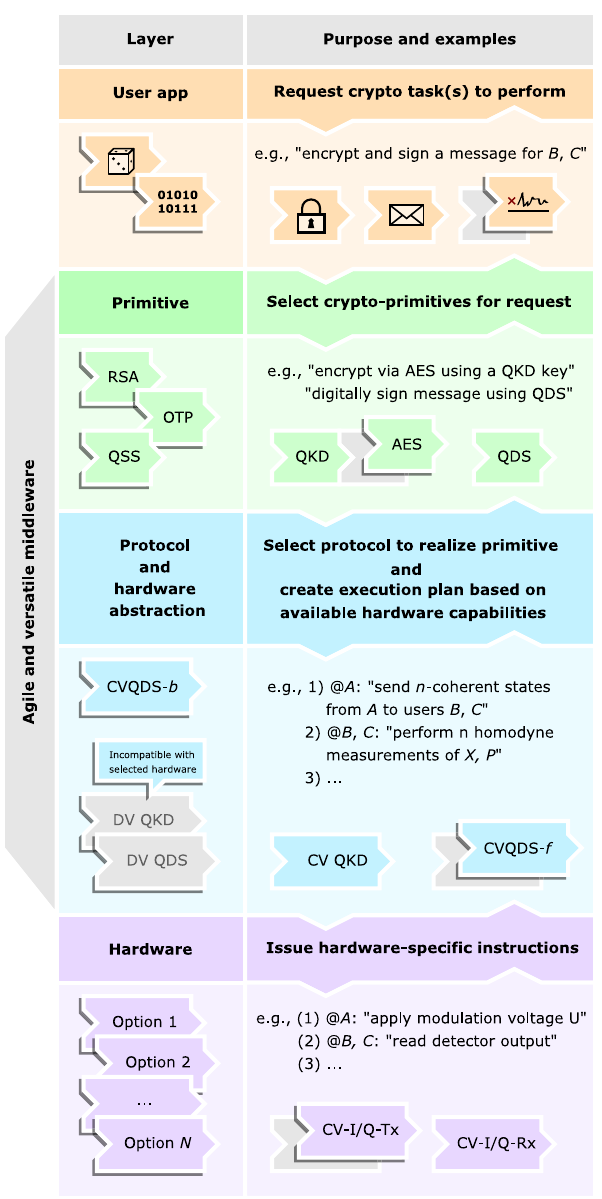
FIG. 2. A layer-based description of an agile and versatile quantum cryptosystem showing how its modular and decoupled componentscanbeswappedoutandrecombinedsimilarlytopuzzle pieces. Quantum cryptoagility and versatility can both be realized by introducing a middleware (a collection of interface layers) between the user application (yellow) and quantum hardware (purple) layers. This requires that the hardware drivers expose a set of standardized functions to the layers above it. The middleware can then select suitable quantum cryptoprimitives and hardware- compatible protocols to fulfill a given user request for a given cryptographictask.Inthismanner,themiddlewarelayersgeneralize and extend the functions of a key management system. For some of the acronyms in this figure, please refer to the caption of Fig. 1. CV-I/Q-Tx and CV-I/Q-Rx denote sender (Tx) and receiver (Rx) hardwaremodulescapableofperformingcontinuous-variable(CV) quadrature (I/Q) modulation and